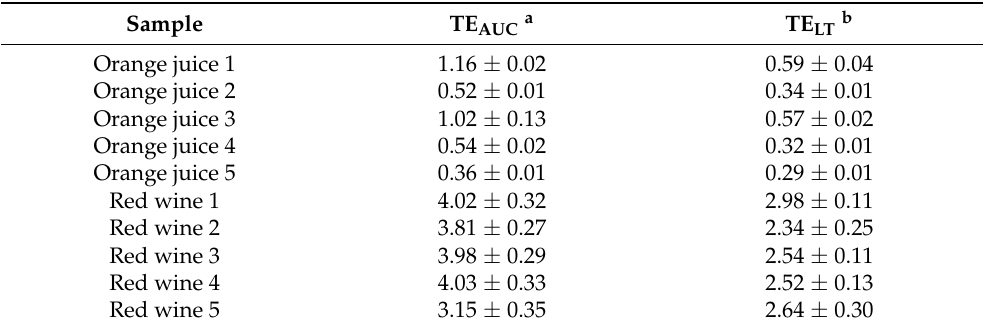
Table 4. ORAC values calculated from AUC and lag time (LT) values obtained for orange juice and red wine samples.